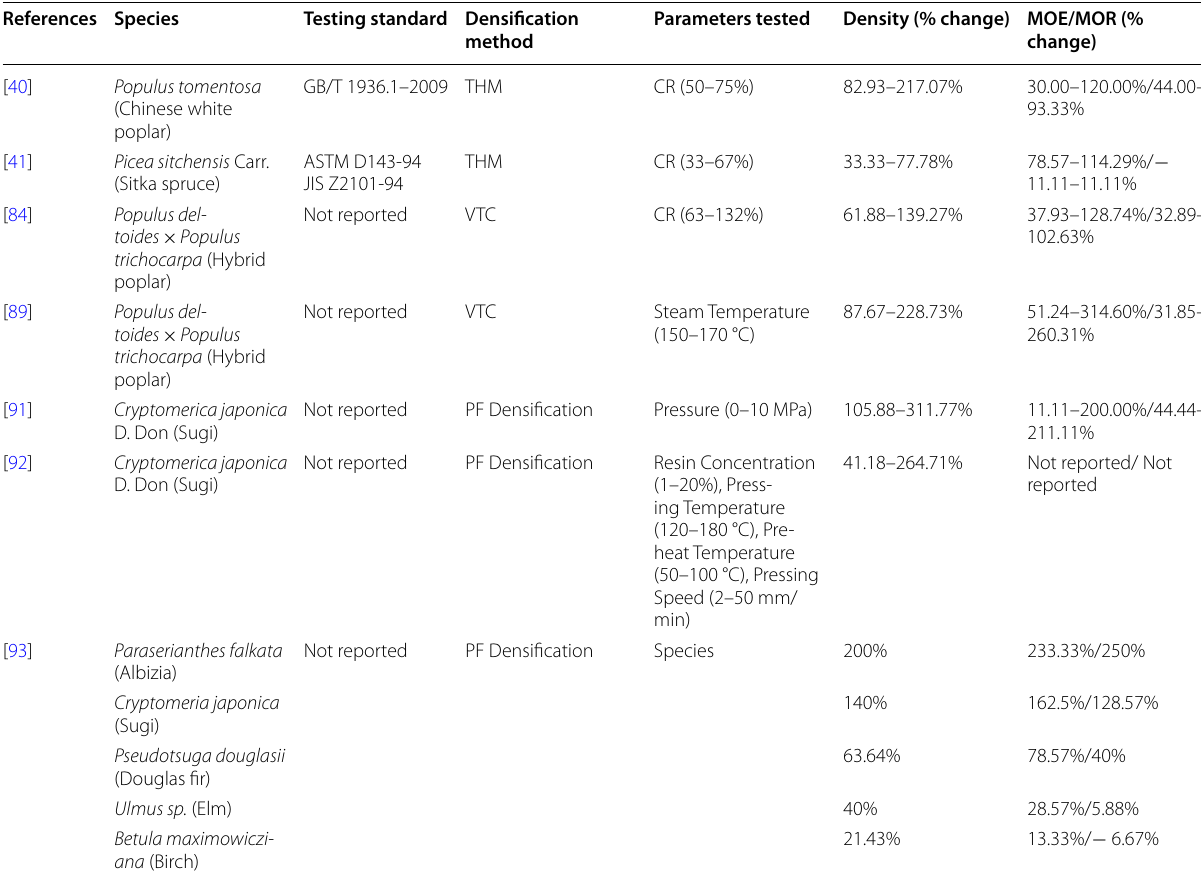
Table 3 Summary of MOE and MOR of densified timber from various densification method research